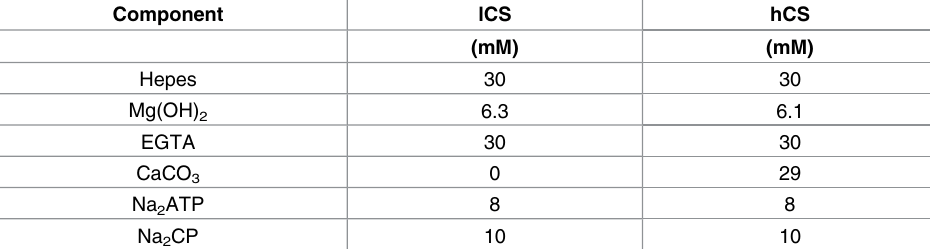
Table 1. Composition of physiological stock solutions with low calcium content(lCS) and high cal- cium content